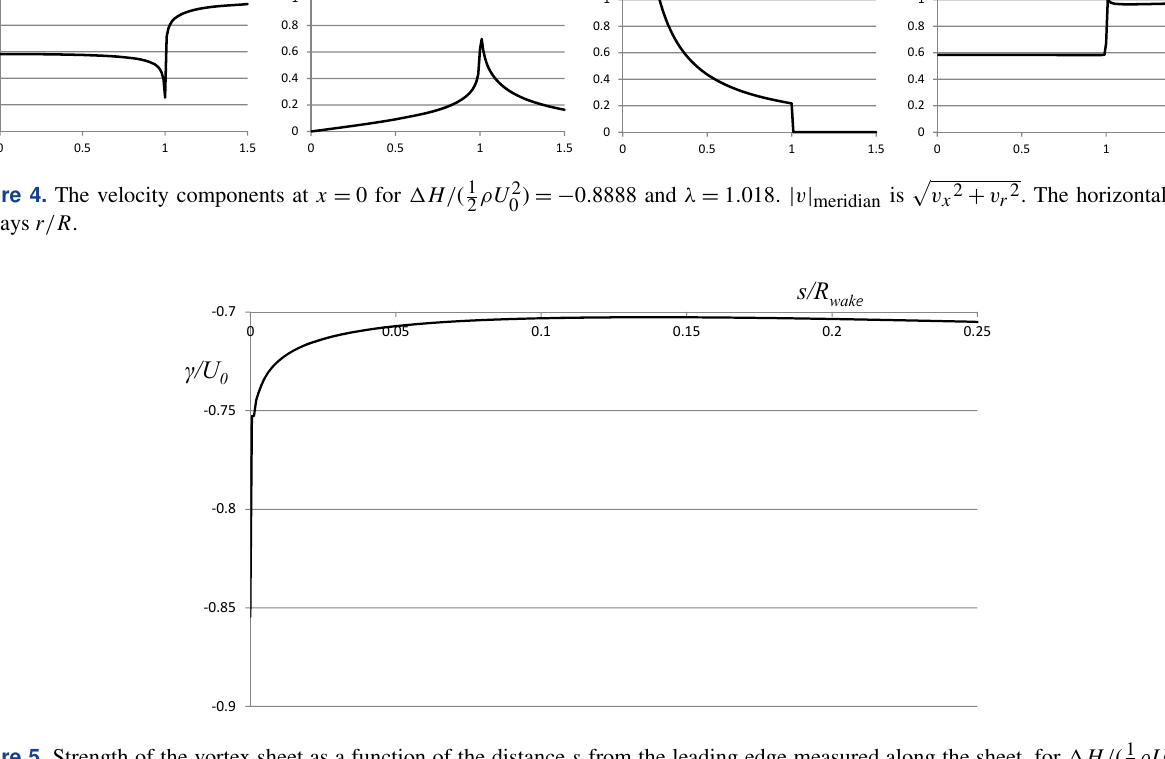
Figure 5. Strength of the vortex sheet as a function of the distance s from the leading edge measured along the sheet, for (cid:49)H/ ( 1 − 0 . 8888 and λ = 1 . 018 .